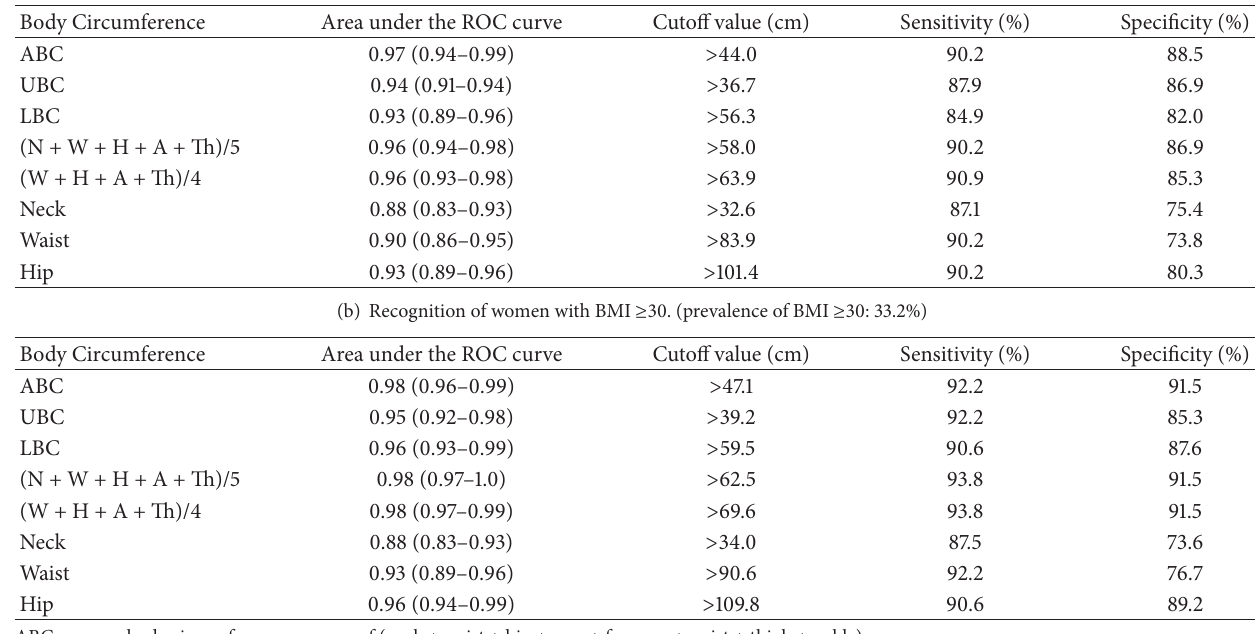
Table 4: ROC analysis for the recognition of women with BMI ≥ 25 or BMI ≥ 30 using body